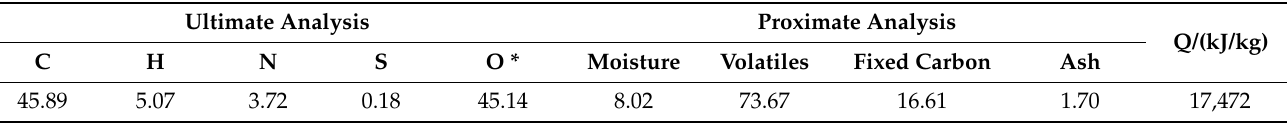
Table 1. The ultimate analysis and proximate analyses of the wood waste (wt.%).